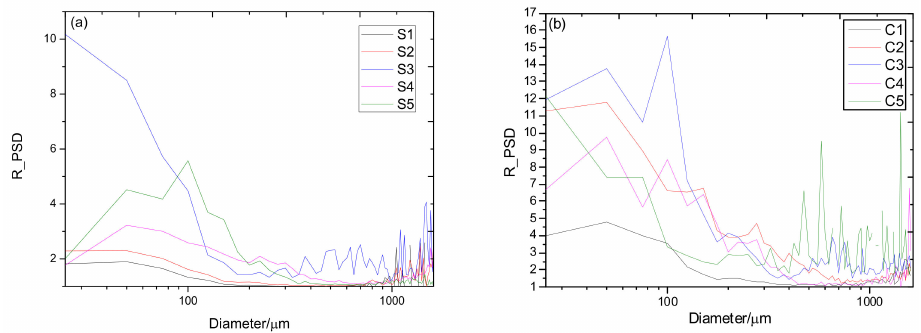
Figure 4. Ratio distribution of the cloud particle number concentration with diameter in different cloud types: ( a ) stratiform; ( b )